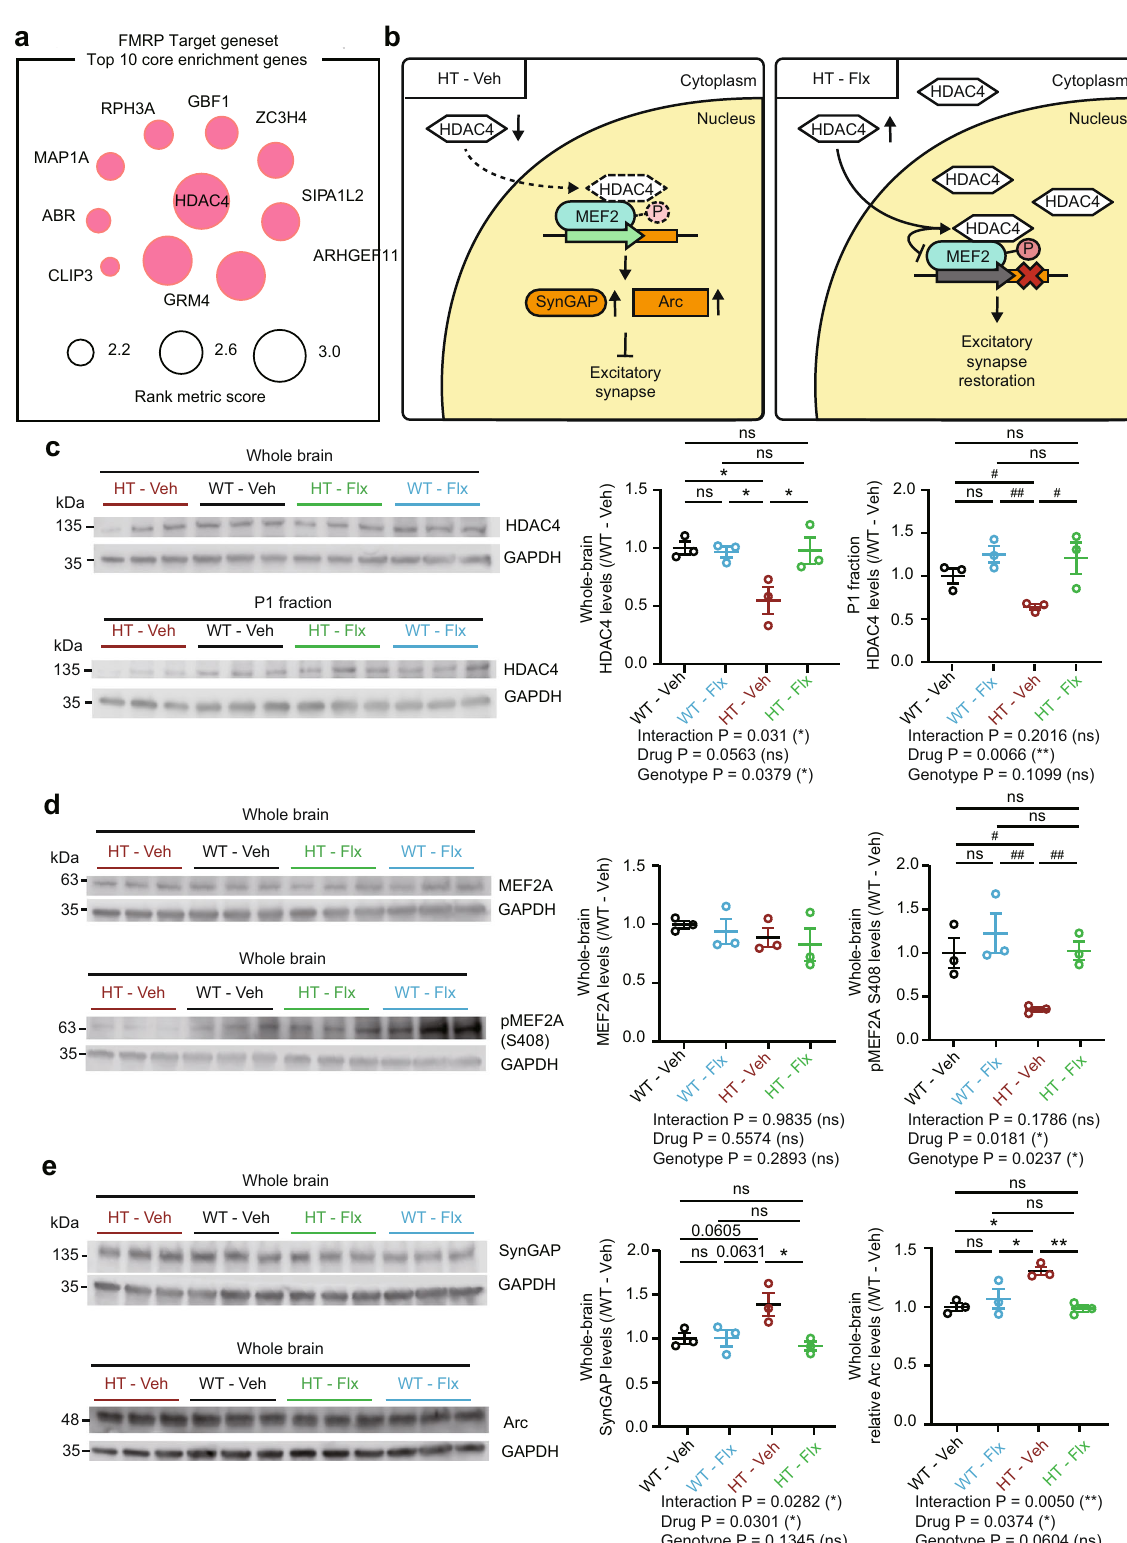
dependent inhibition of the MEF2A transcription factor (Fig. 7d), known to inhibit excitatory synapses 50 – 57,68 by promoting the expres- uoxetine-treated whole brain and mPFC of Arid1b +/ – mice (Fig. 7e